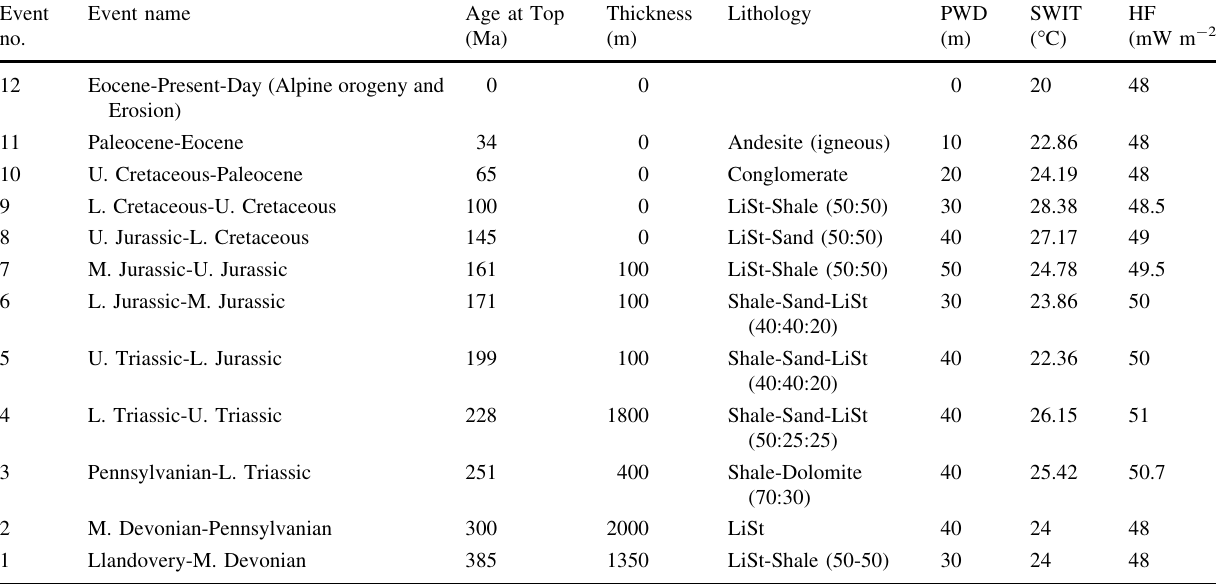
Table 2 Input data used for modeling the burial and temperature history in the Parvadeh Area (see Table 3 for physical rock properties) Event no.